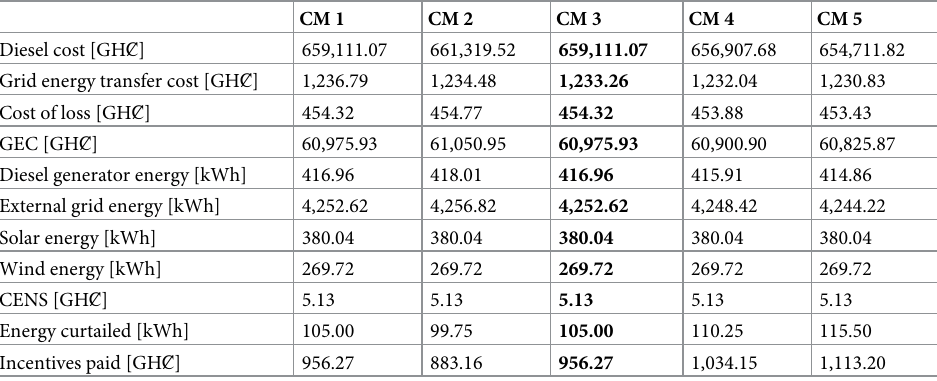
Table 14. Influence of varying CM on a network–case 1.